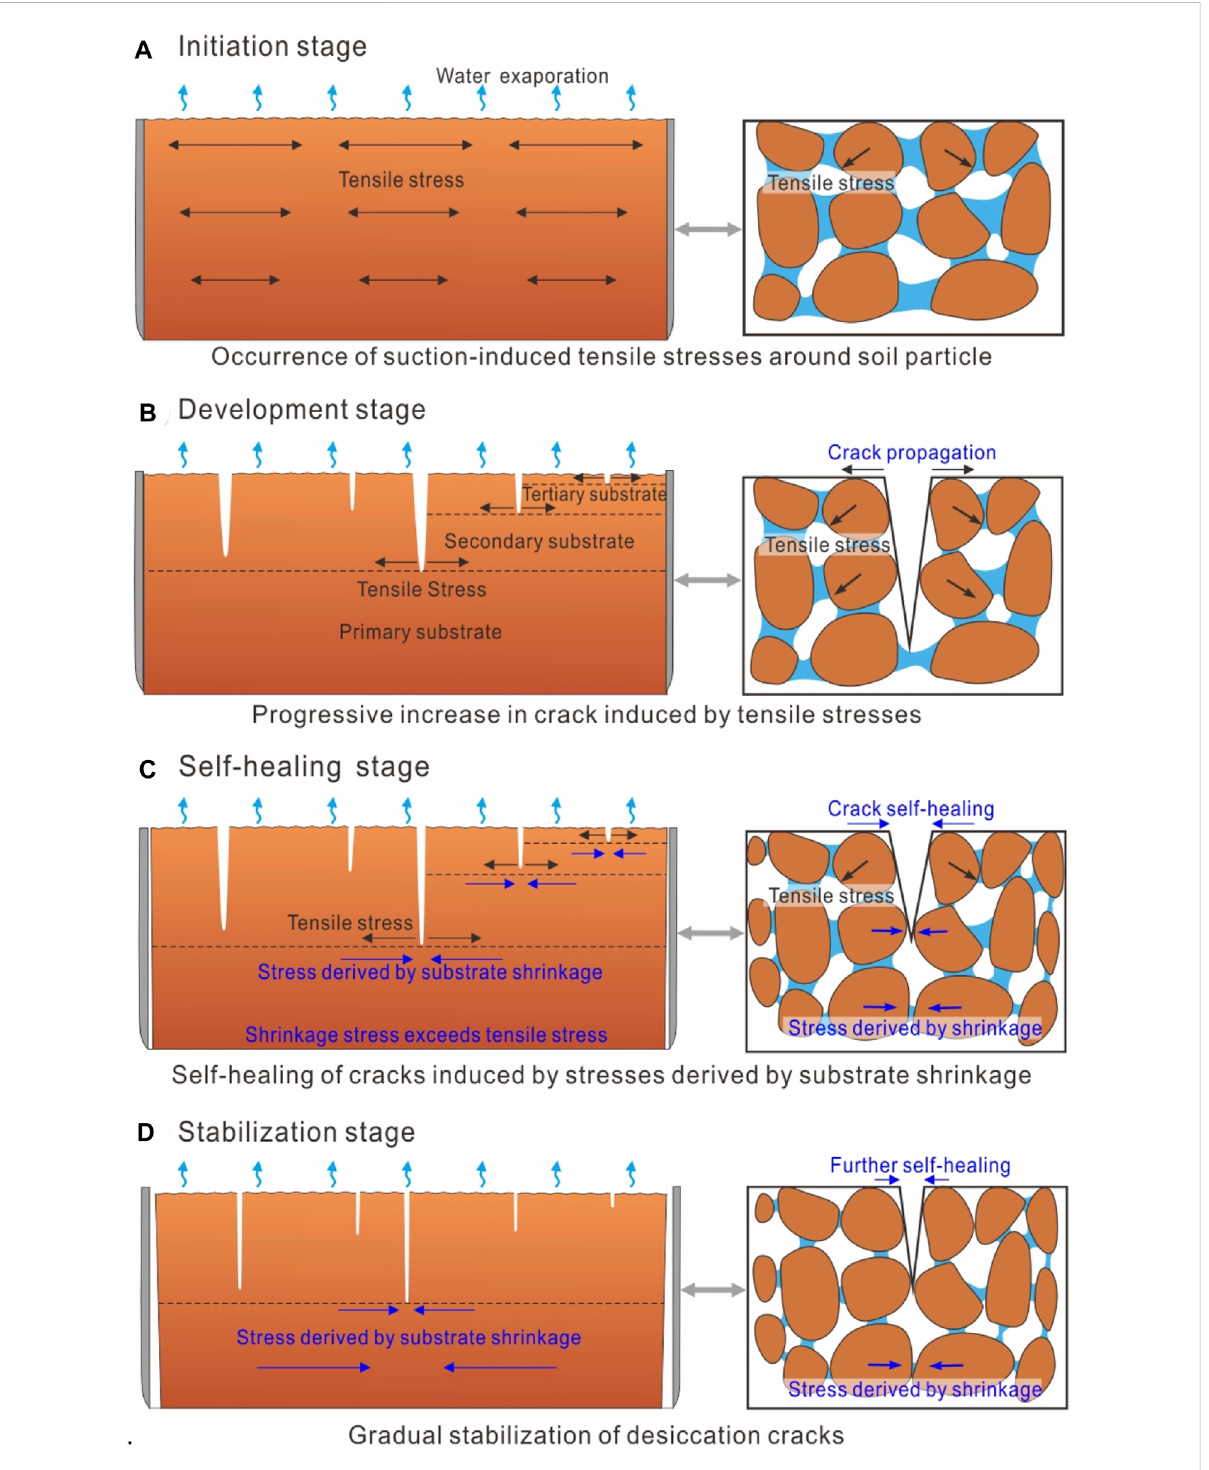
FIGURE 14 Schematic diagram of desiccation cracking mechanism in compacted Hipparion red clay. (A) Occurrence of suction-induced tensile stresses around soil particle with water evaporation, (B) Crack propagation in different substrate region induced by tensile stresses, (C) Occurrence of self- healing of cracks induced by stresses derived by substrate shrinkage, and (D) Gradual stabilization of desiccation cracks.